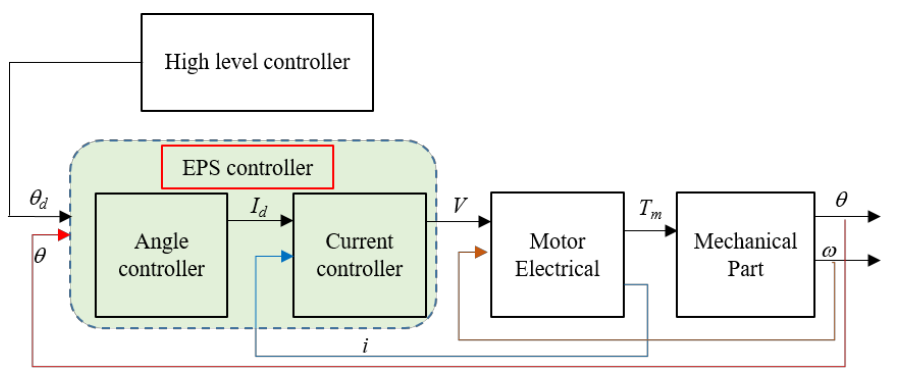
Figure 1. Functional diagram of the automatic steering system.